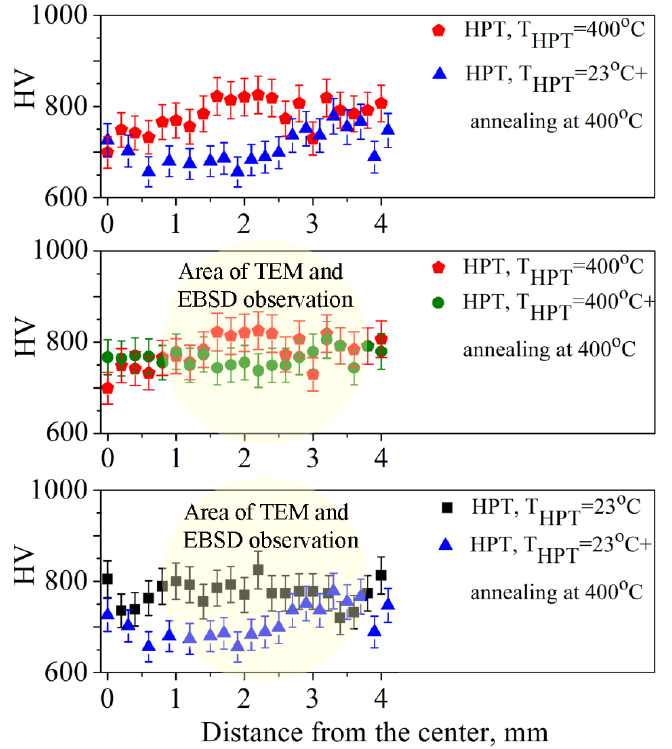
Figure 7. Effect of HPT and subsequent annealing on distribution of microhardness across diameter of the specimen.